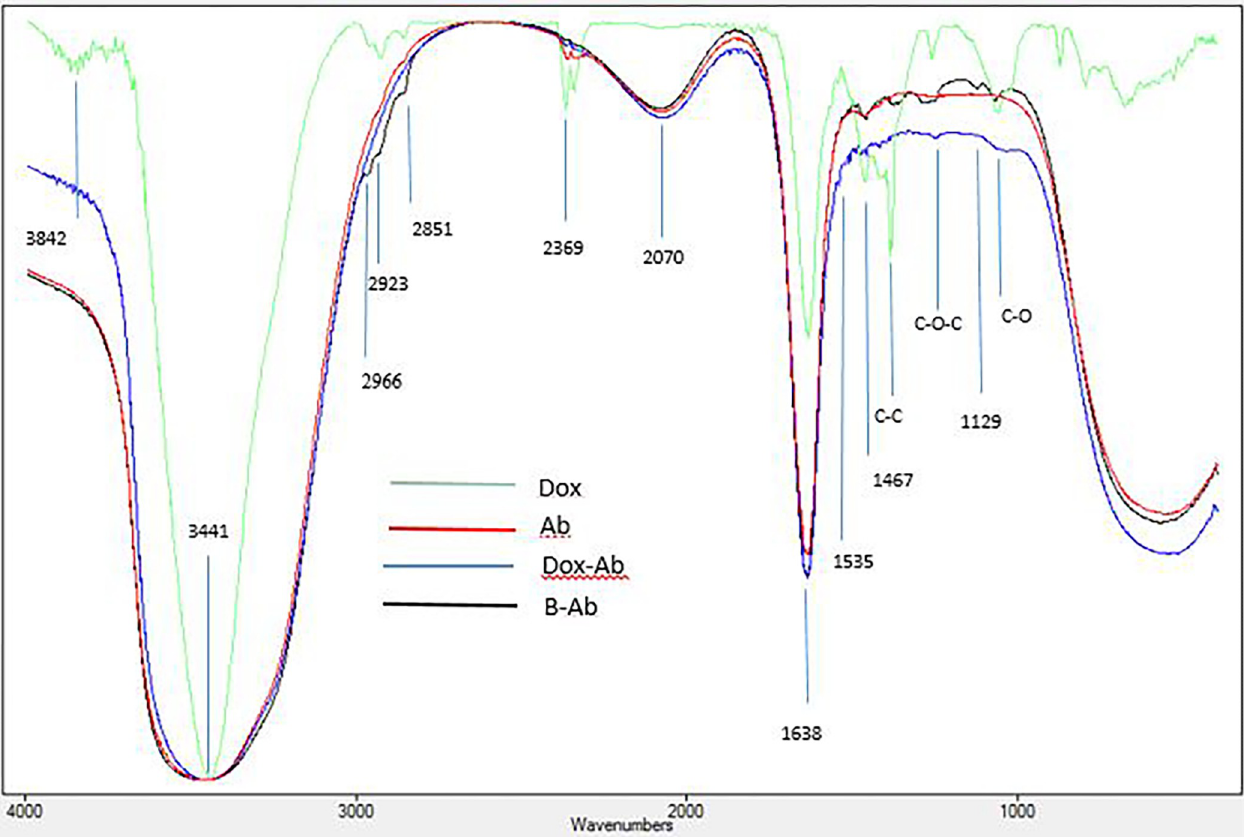
Fig 2. The Attenuated Total Reflection Fourier-Transform Infrared Spectroscopy (ATR-FTIR) analysis of the antibodies conjugated to doxorubicin (Ab- Dox) and bacterial antigens (B-Ab), purified anti-MCF7 antibodies (Ab) and doxorubicin (Dox).